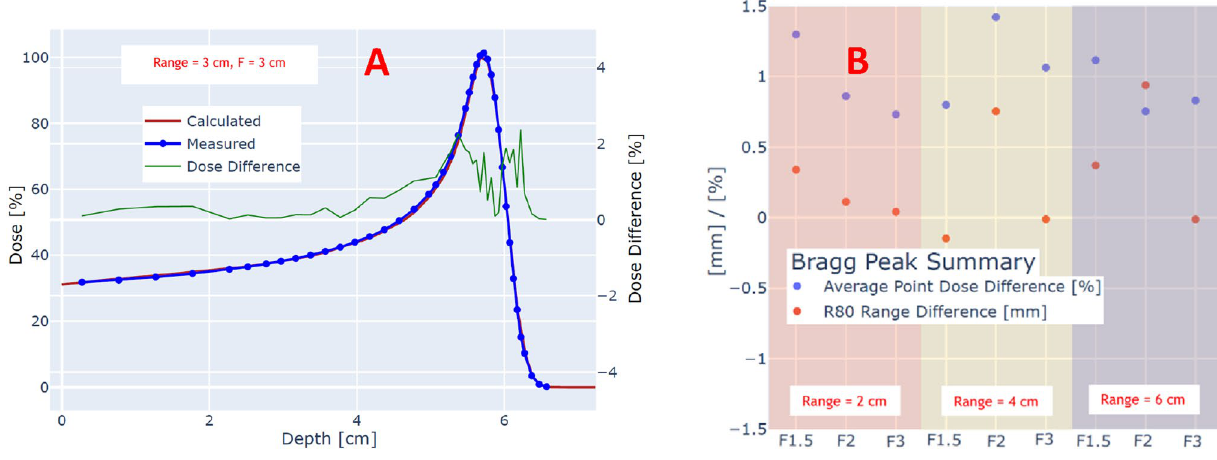
Figure 2. ( A ) Depth dose comparison between measured and calculated Bragg peak with a range of 3 cm and circular field size of 3 cm. The local error between measurement and calculated is shown with a green line. ( B ) Average point dose and R80 range differences for ranges 2, 4, and 6 cm as a function of circular field size.